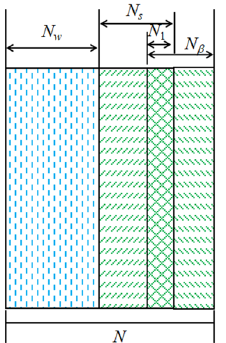
Figure 1. Axial elements diagram of